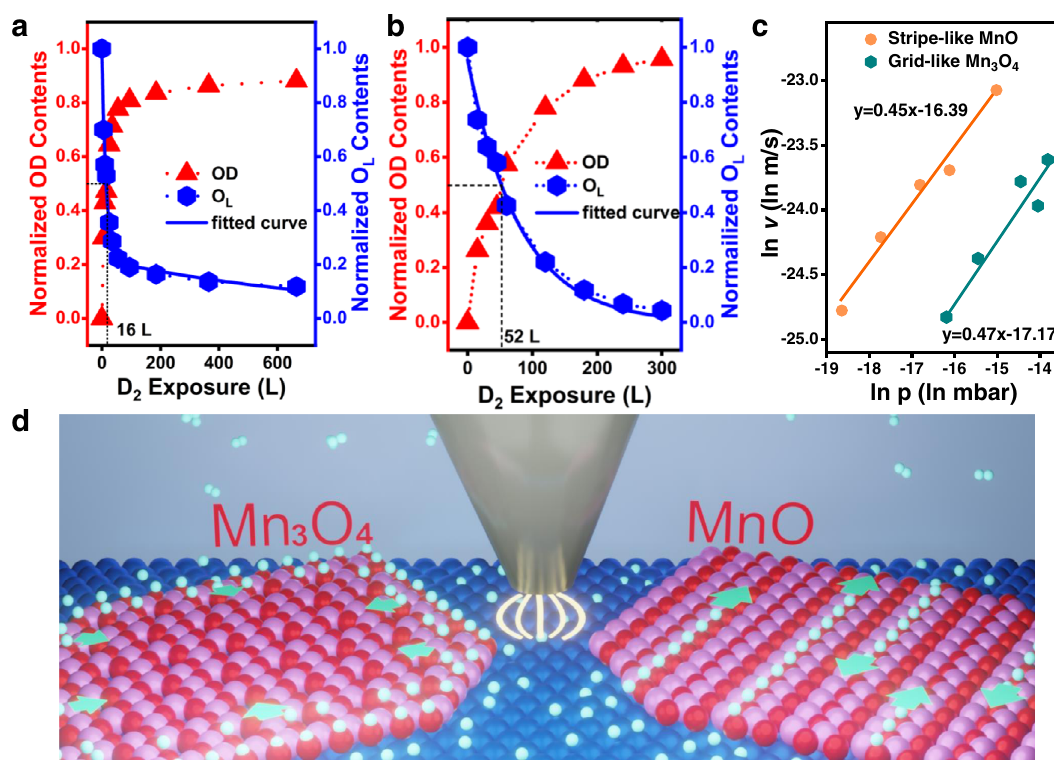
Fig. 4 | Hydrogen spillover rates on MnO and Mn 3 O 4 . OD and O L contents derived from the XPS O 1 s areas of ( a ) stripe-like MnO and ( b ) grid-like Mn 3 O 4 surfaceswithdifferentamountofD 2 exposure. c Dependenceofspilloverratesof stripe-like MnO and grid-like Mn 3 O 4 surfaces on H 2 partial pressure. The